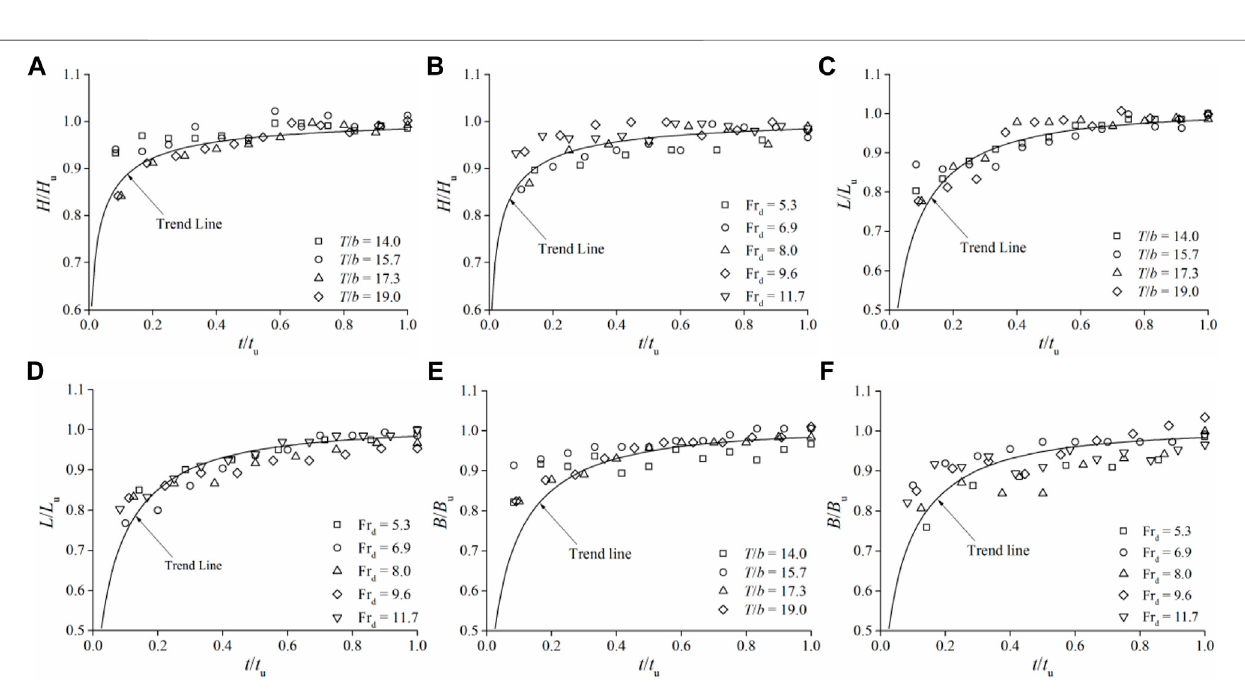
Frontiers in Earth Science |